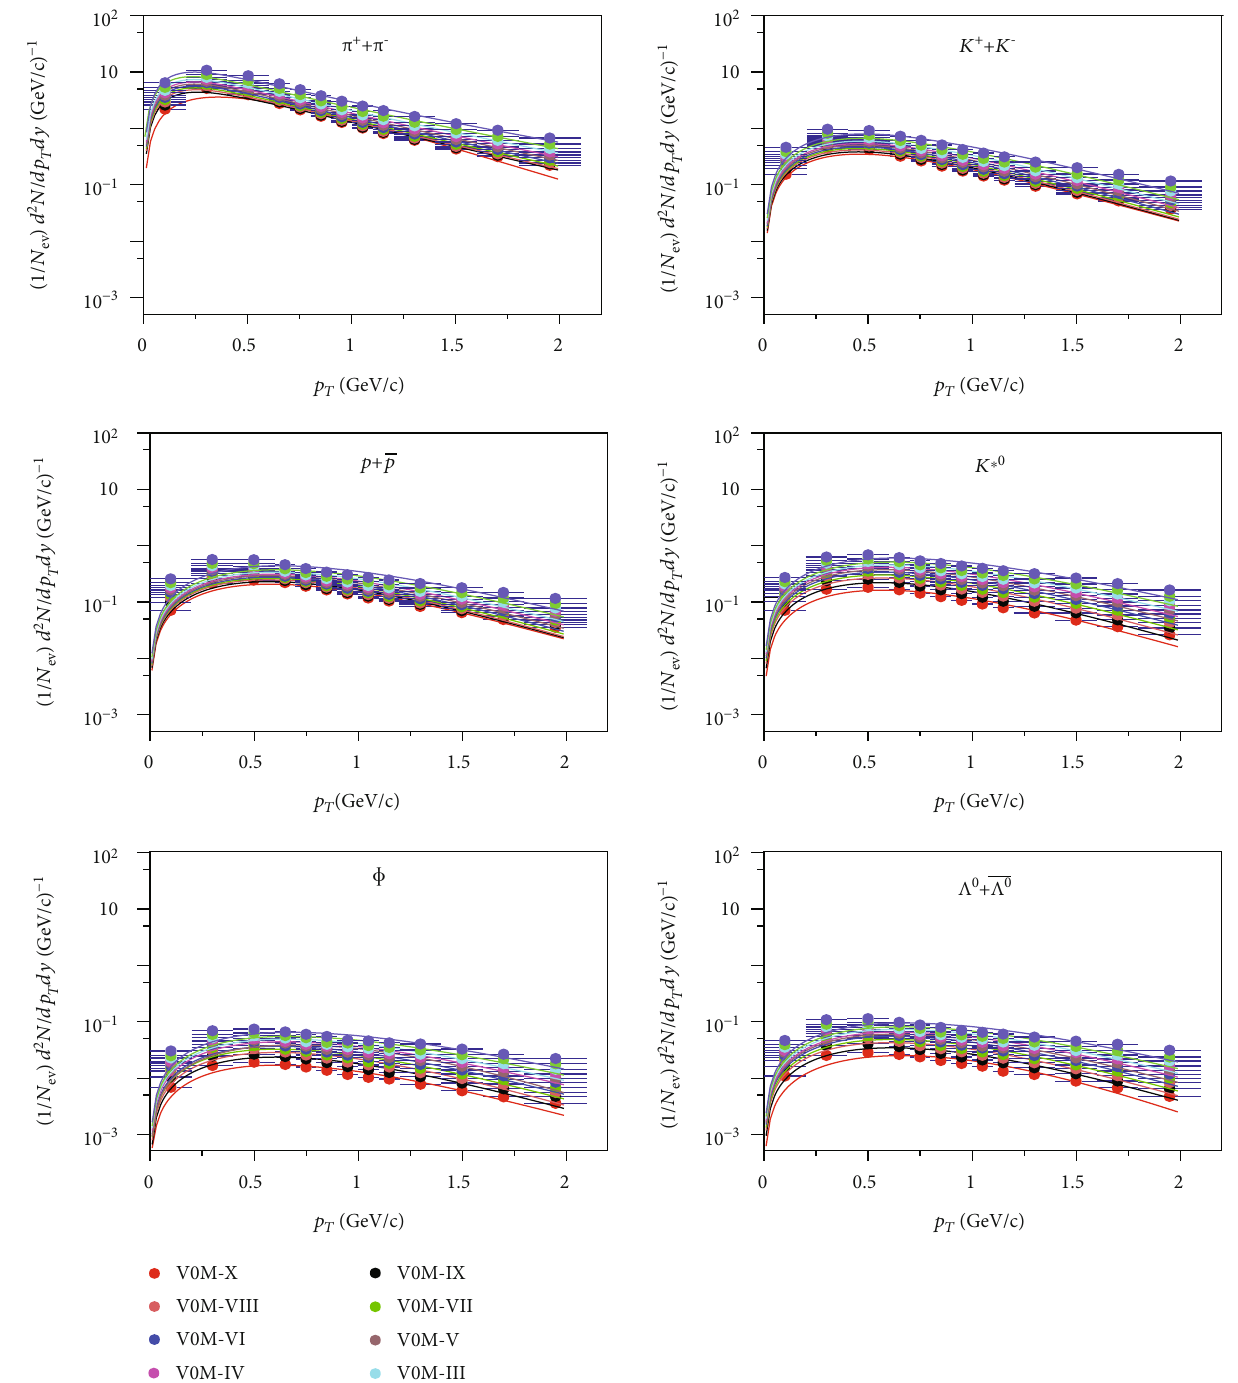
Figure 13: (Color online) Fitting of generated p various multiplicity classes as shown in Table